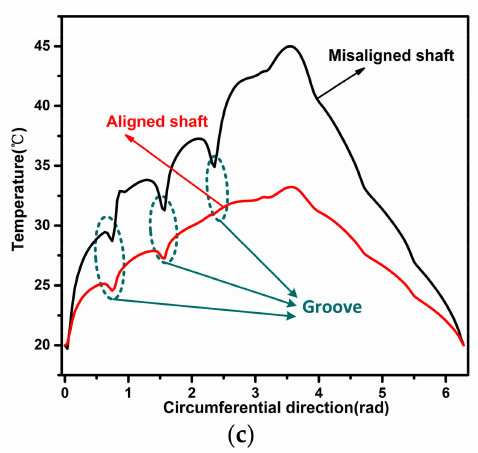
Figure 12. Comparisons of temperature distribution of the water film obtained with a misaligned shaft case and an aligned shaft case under different axial sections of the WLRSB: ( a ) at z/L = 0.5; ( b ) at maximum temperature; ( c ) at z/L =